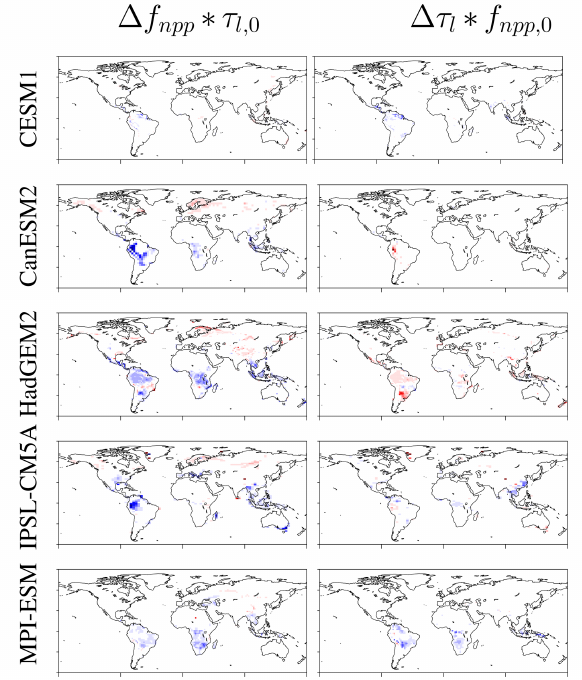
Figure 6. Responses of linearized equilibrium live carbon pools (kgCm − 2 over the interval of CO 2 doubling) in radiatively coupled (esmFdbk1) run. Left column shows productivity-driven changes to b C l . Right column shows turnover-driven changes to b C l .